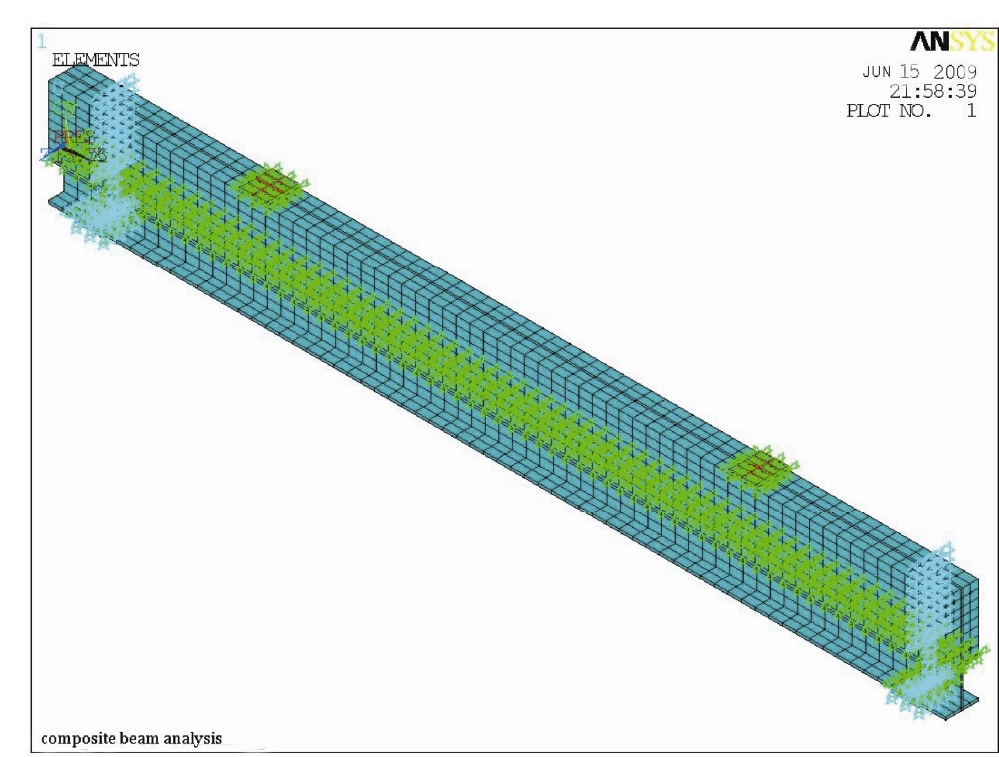
Fig. 5. Shaped steel-concrete composite beam modelling